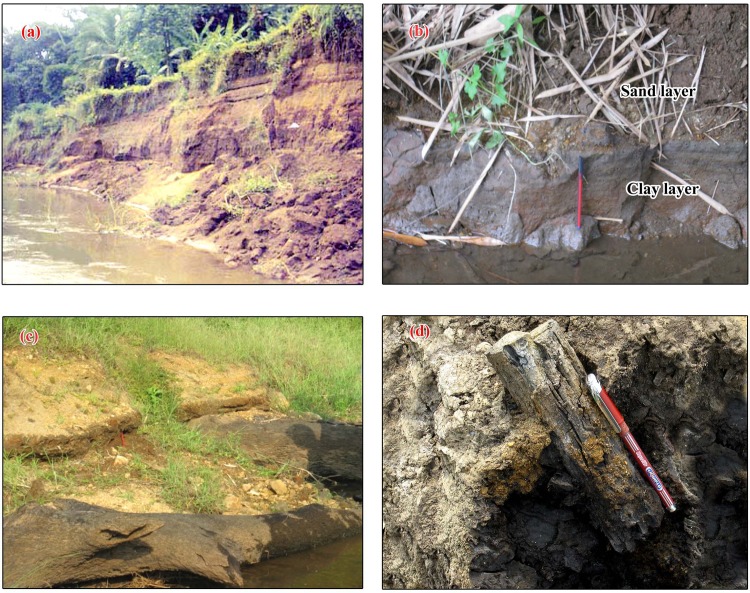
Selected field locations and sections from the study area—(a) Pamba river bank exposing yellowish brown, silty mud with intercalations of sand (b) Carbonaceous clay—sand sequence exposed on the bank of Manimala River near Karippumuri kadavu (c) Huge tree trunks exposed on bottom of the bank of Manimala River (d) A piece of wood embedded in the carbonaceous clays excavated from the Achankovil river basin (near Vettiyar) during the process of a canal construction through its floodplain.